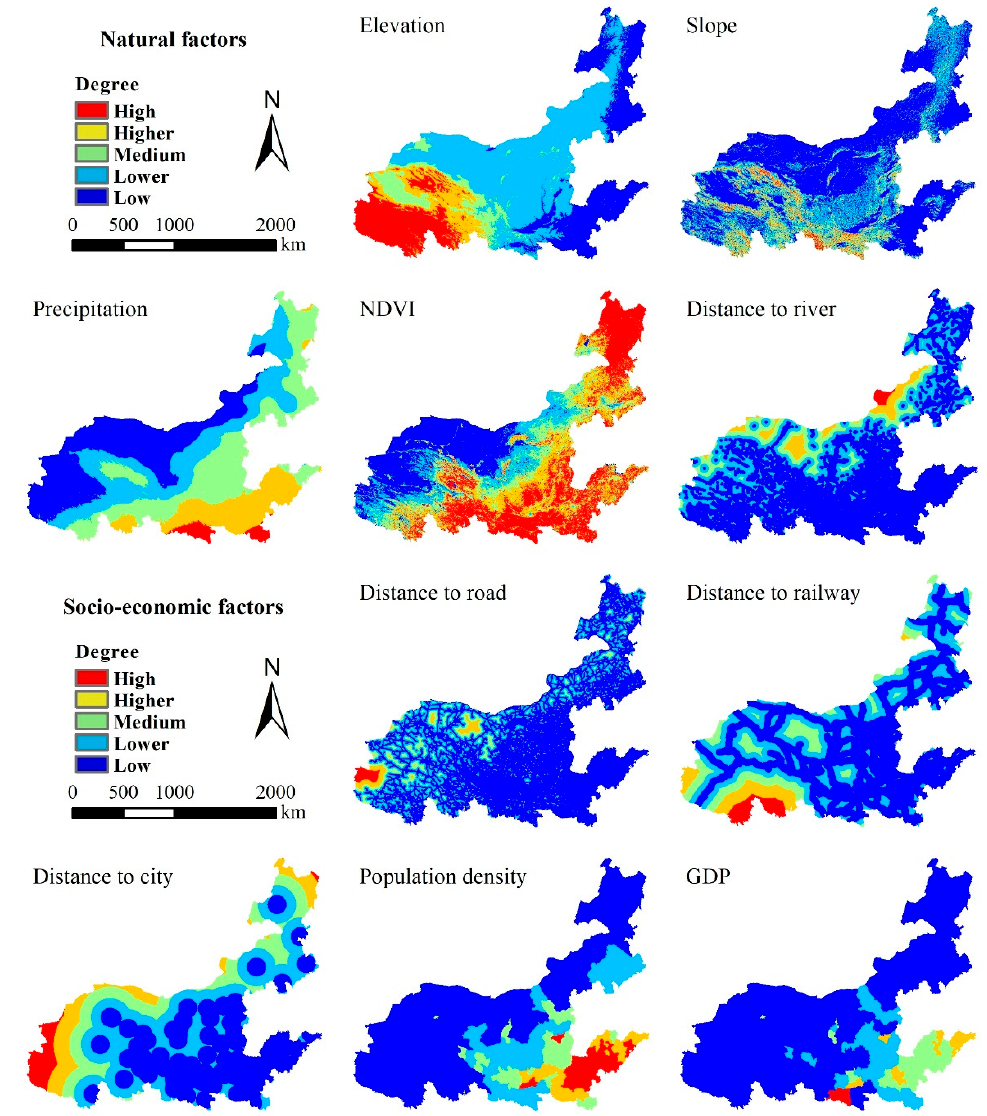
Figure 2. Influencing factors of ESV change.